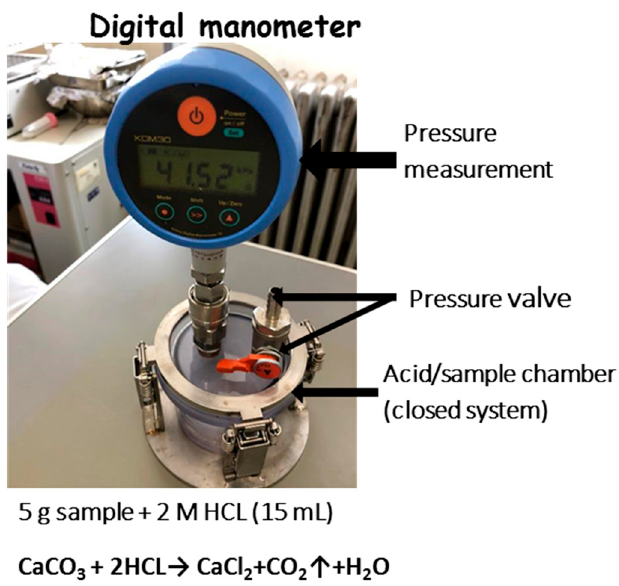
Figure 6. Digital manometer setup used to measure the CaCO 3 content. Table 4. Testing conditions for the sand solidification test (syringe) considering fiber content (%).